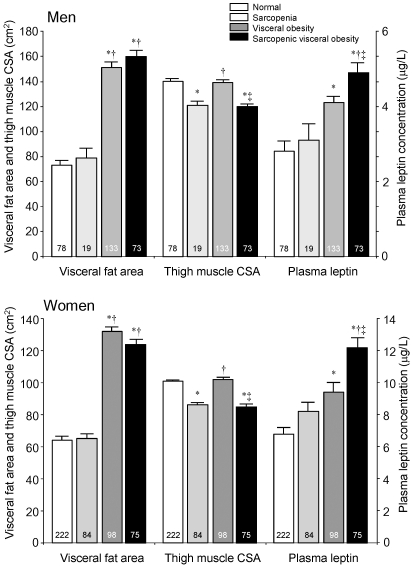
Visceral fat area, thigh muscle cross-sectional area (CSA) and plasma levels of leptin in subjects with sarcopenia, visceral obesity, and sarcopenic visceral obesity.Corrected for age and body weight. Values are mean ± standard error. *p<.05 vs. normal, †p<.05 vs. sarcopenic, ‡p<.05 vs. visceral obesity.